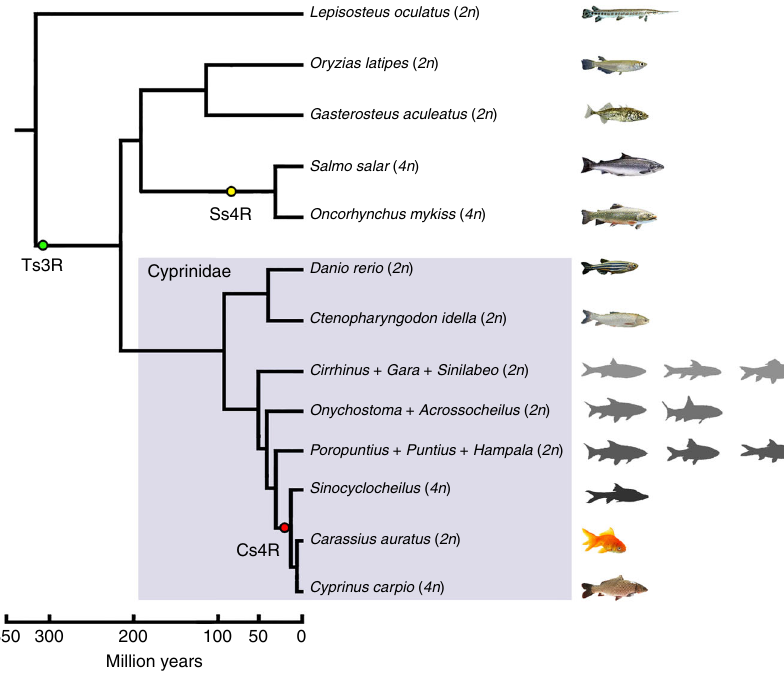
Fig. 1 Phylogenetic relationship of tetraploid Cypinidae and relevant teleost lineages. The phylogenetic topologies and divergence ages are taken from the TimeTree database (ref. 11 ) and ref. 12 . Green, yellow and red circles represent the teleost-speci fi c whole genome duplication (Ts3R), salmonid-speci fi c whole genome duplication (Ss4R) and carp-speci fi c whole genome duplication (Cs4R), respectively. The fi sh images are either collected and created by us (including Cyprinus carpio , Ctenopharyngodon idella , Oryzias latipes , Danio rerio , Cirrhinus , Garra , Sinilabeo , Onychostoma , Acrossocheilus , Poropuntius , Puntius , Hampala and Sinocyclocheilus ) or obtained from public domains (including Lepisosteus oculatus , Gasterosteus aculeatus , Salmo salar , Oncorhynchus mykiss and Carassius auratus